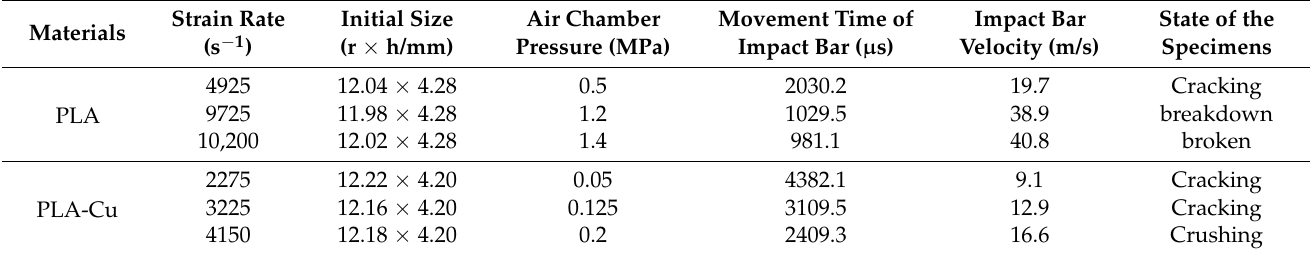
Table 9. SHPB experimental scheme.